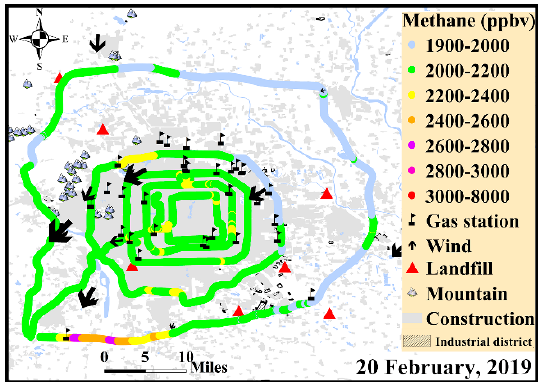
Figure 4. CH 4 concentration map as a function of location in wintertime.